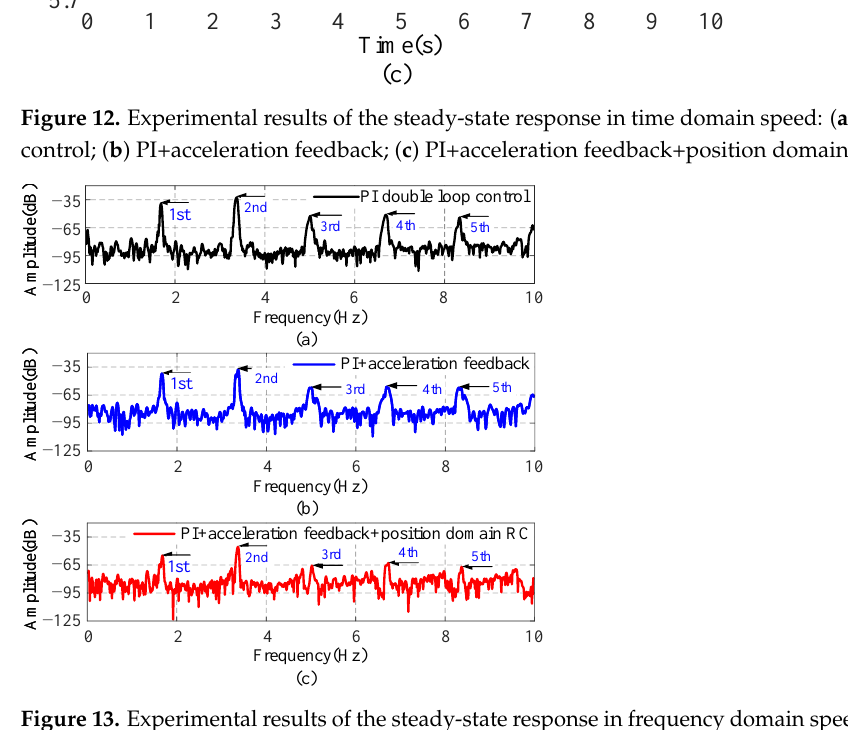
Figure 13. Experimental results of the steady-state response in frequency domain speed: ( a ) PI double loop control; ( b ) PI+acceleration feedback; ( c ) PI+acceleration feedback+position domain